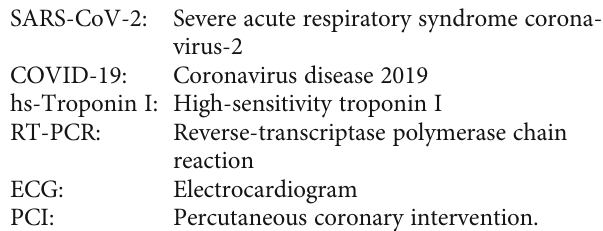
Supplementary 1 . Video 1 . Transthoracic echocardiogram exhibiting severely reduced left ventricular ejection fraction (20-25%), hypokinesis of the mid- to distal segments of the inferior, inferoseptal, anterior, and anteroseptal walls with apical akinesis. Supplementary 2 . Video 2 . The left ventricle is normal in size with normal left ventricular wall thickness. Left ventricular systolic function is severely reduced. Ejection fraction = 25- 30%. Dynamic heart model LVEF =29%. The basilar antero- septum is markedly hypokinetic. There is thinning and scarring of the mid-anteroseptum, anterior, and anterolateral wall segments. The apex is dilated, thinned, and